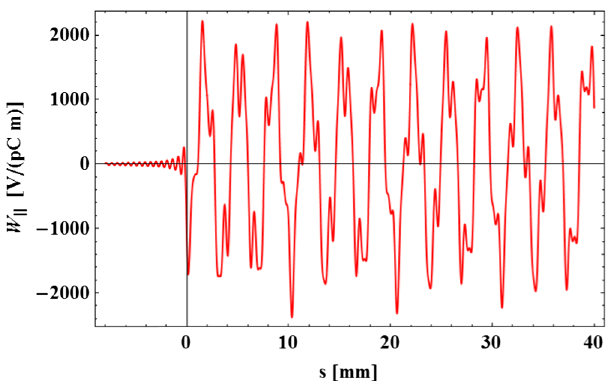
FIG. 8. Comparison of the sum of the first two resonance contributions to the wake function (red, dashed line) with the full wake function (black, solid line) for ε 00 1 ¼ 0 . 5